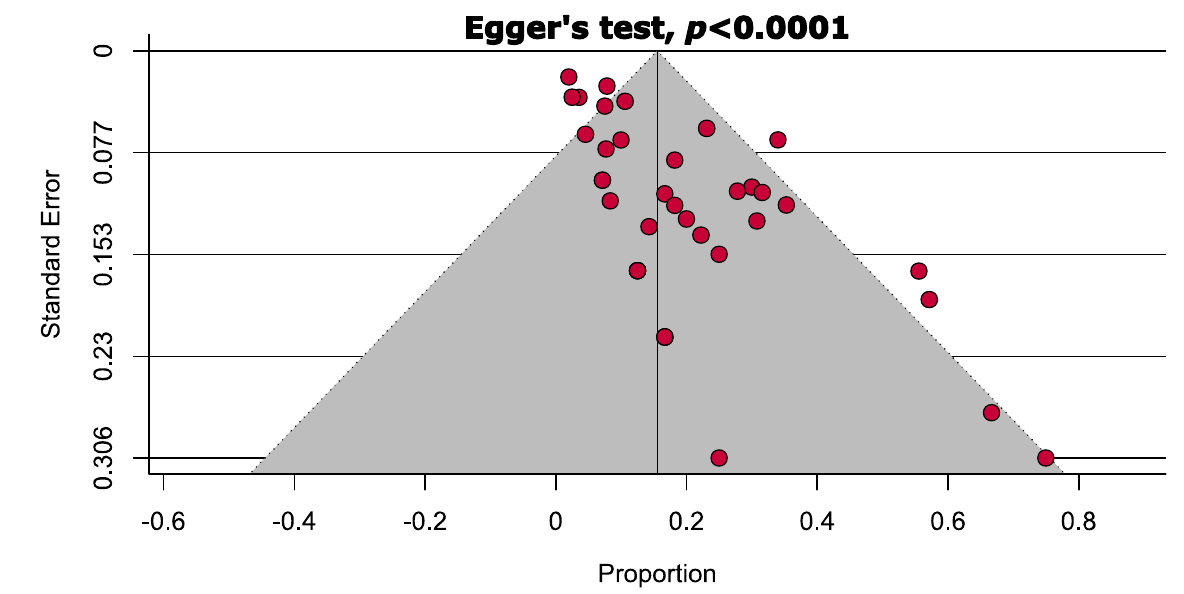
Figure 2. Publication bias assessing the prevalence of local recurrence following cryosurgery of giant cell tumour of bone.